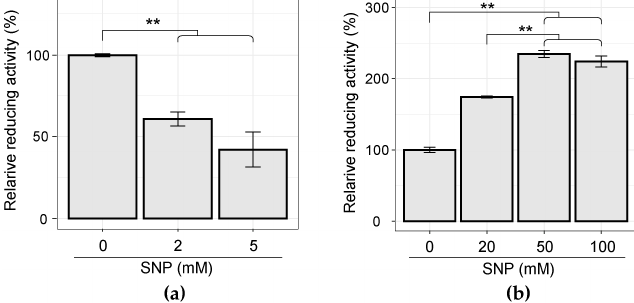
Figure 7. Relative WST-8-reducing activity of SNP-treated cells as determined by WST-8 reduction assay. Reduction of WST-8 to formazan by NADH in F. nucleatum subsp. polymorphum ( a ) and C. concisus ( b ) was measured at 450 nm using a microplate reader. Values are expressed as the mean and standard deviation, calculated from triplicate assays. p -values were calculated by Student’s t -test (** p < 0.01).